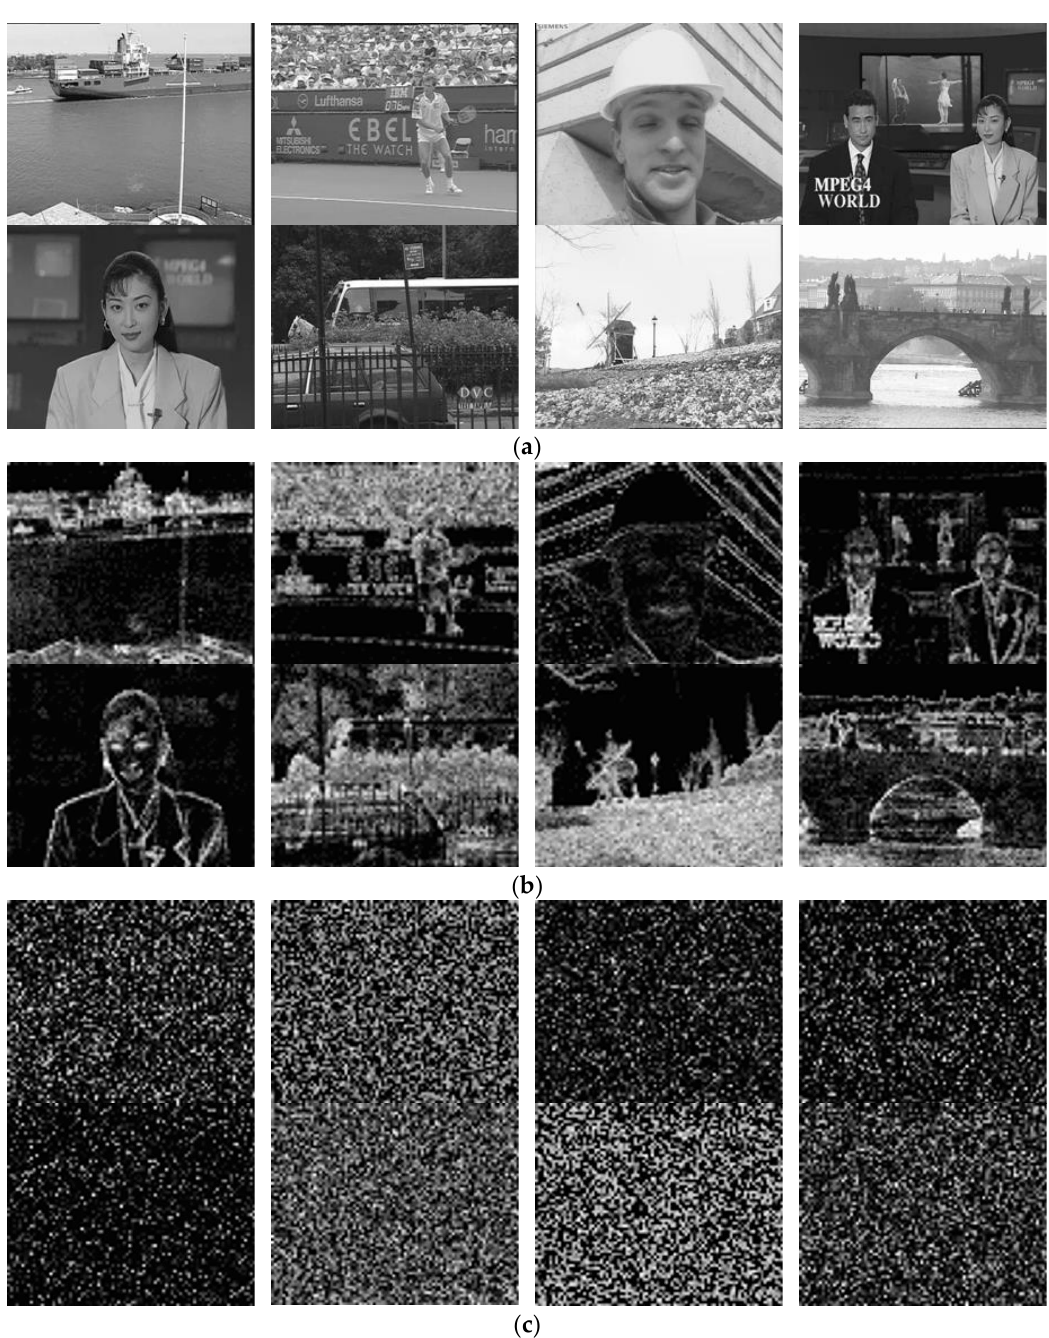
Figure 10. Effect of resisting sketch attack. ( a ) Original frame, ( b ) I-Q-M encryption, ( c ) proposed